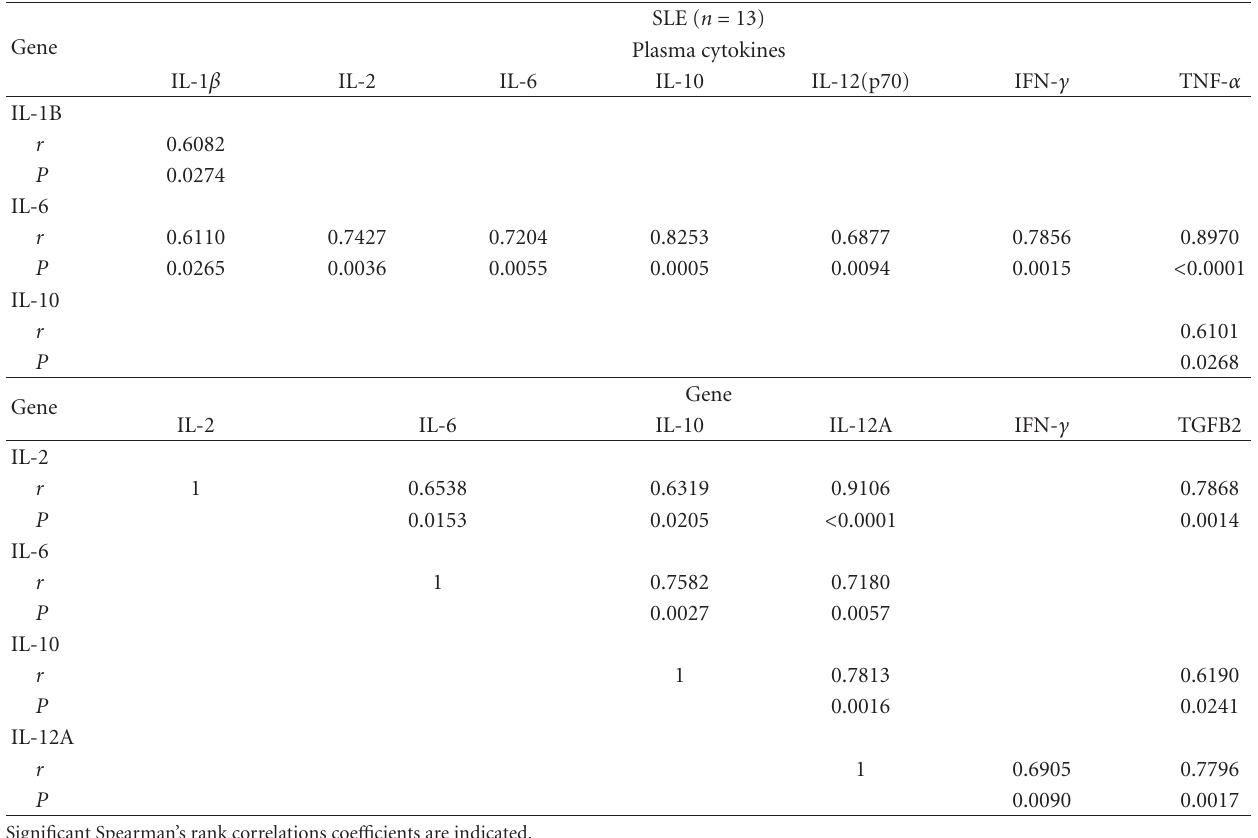
Table 5: Spearman’s rank correlations obtained between cytokines gene expressions in PBMCs and cytokines plasma levels in SLE patients.